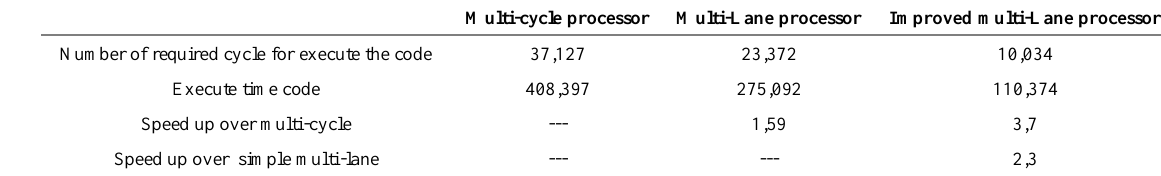
Table 3. Processor efficiency in different